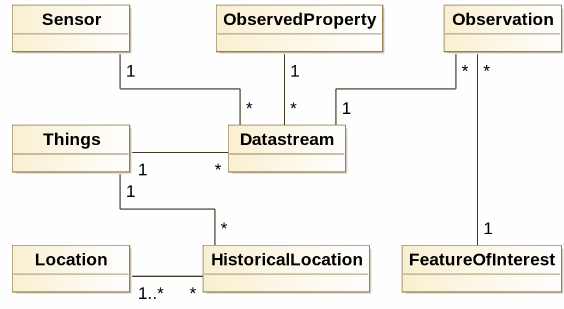
Figure 2. SensorThings API data